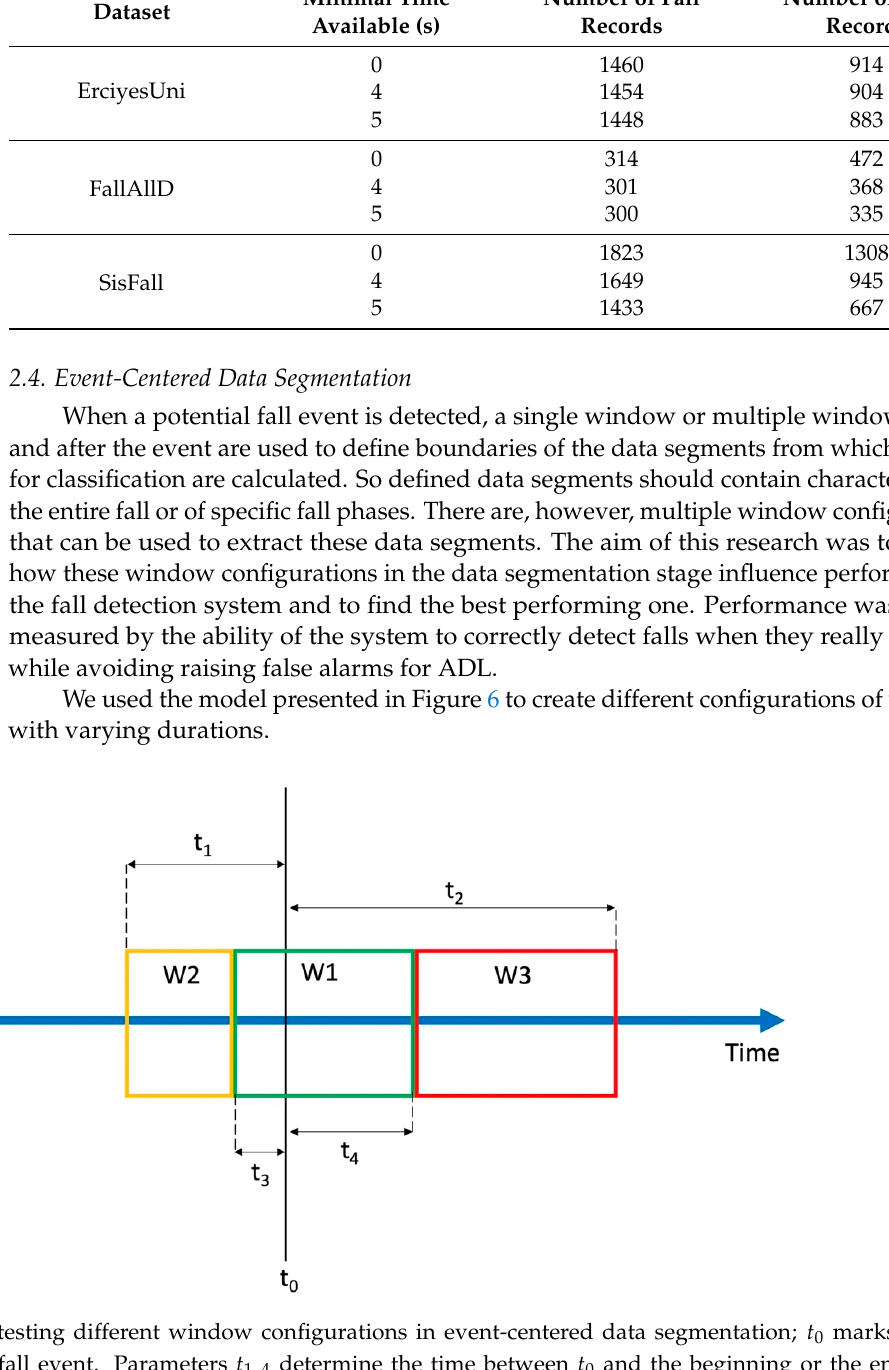
Table 1. The number of event-centered data records referred to the minimal time available before and after a potential fall event.